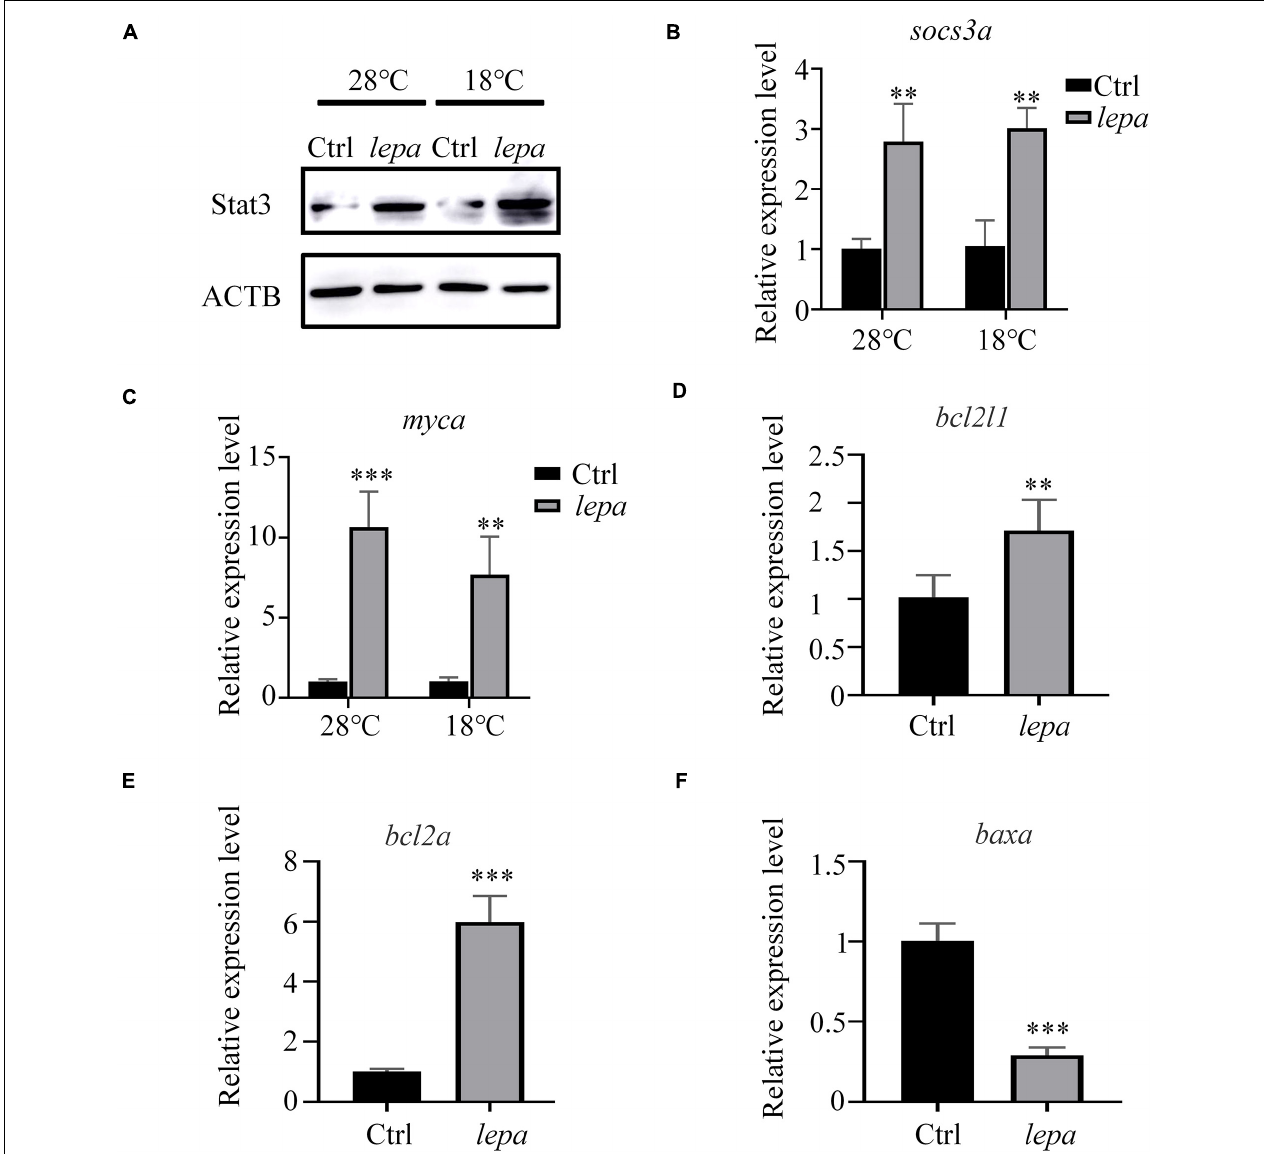
FIGURE 6 | Activation of stat3 signal pathway in DM-lepa-over-expressed cells. (A) Western blot analysis of the protein expression level of STAT3 in the cell lysates of the DM-lepa over-expression group and the control group. (B–F) A qRT-PCR assay of SOCS3/socs3a, c-myc/myca, Bcl-xl/bcl2l1, Bcl2/bcl2a, and Baxa/baxa mRNAs in control and DM-lepa transfected cells. The results are presented as mean ± SD ( n = 3), ∗∗ P < 0.01, ∗∗∗ P <